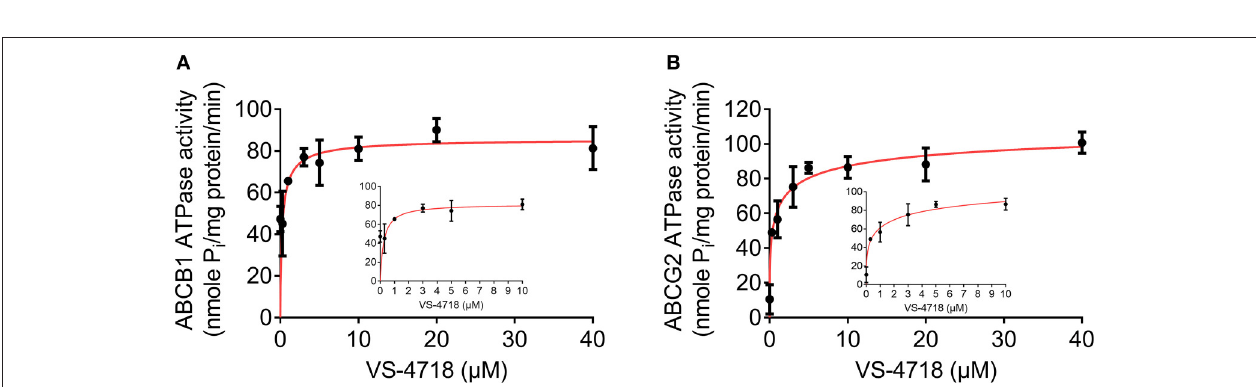
FIGURE 5 | VS-4718 inhibited the efflux function of ABCB1 and ABCG2 transporters. (A,B) The effects of VS-4718 on efflux of [ 3 H]-paclitaxel in KB-3-1 and KB-C2 cells. (C,D) The effects of VS-4718 on efflux of [ 3 H]-mitoxantrone in NCI-H460 and NCI-H460/MX20 cells. Data are mean ± SD , representative of three independent experiments. * p < 0.05, compared with control group.